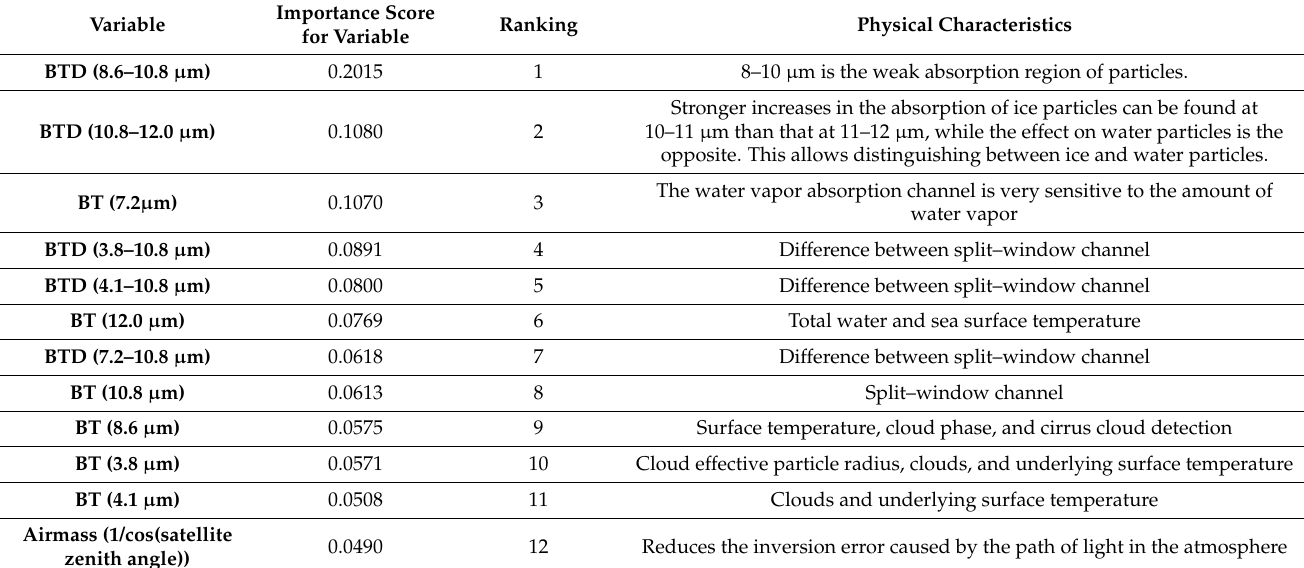
Table 3. The importance scores of predictive variables in the RF model and their corresponding rankings based on the configuration n_estimators= 400, max_depth = 20, min_samples_split = 2, min_samples_leaf = 7, and max_features = 4 for CP